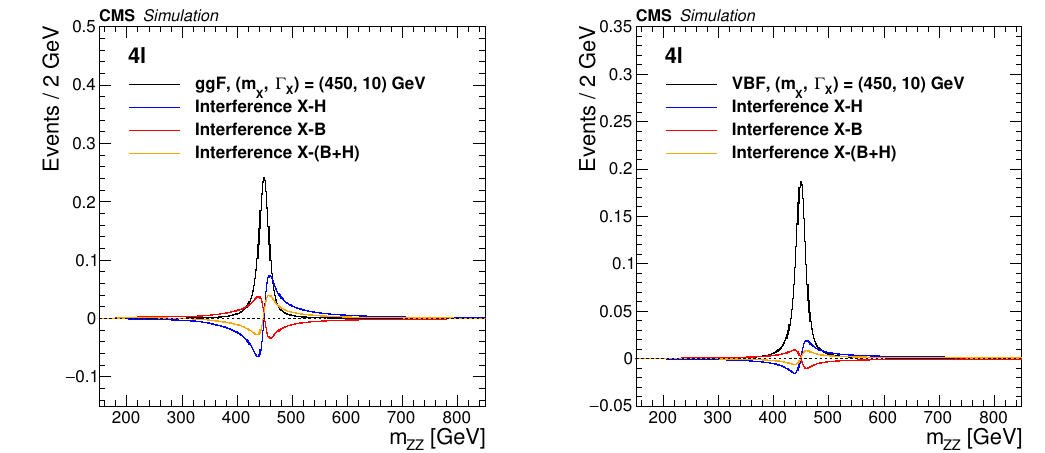
Figure 8 . Parameterizations of the four lepton invariant mass for ggF (left) and VBF (right) production modes, for m X = 450 GeV, (cid:0) X = 10 GeV. The interference contributions from H(125) and gg ! ZZ or VV ! ZZ are also shown. The signal cross section used corresponds to the limit obtained in the 4 ‘ (cid:12)nal